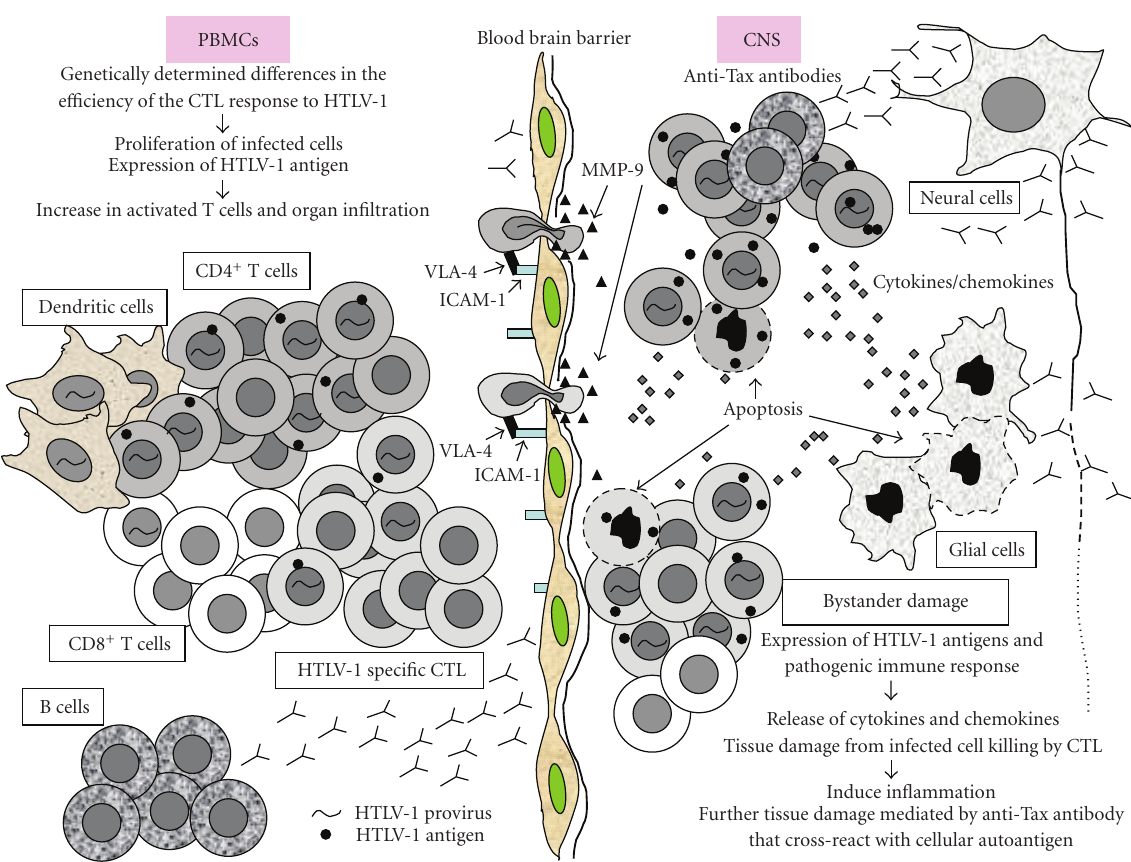
Figure 1: Hypothesis for the pathogenesis of Human T-cell leukemia virus type 1- (HTLV-1-)associated myelopathy/tropical spastic paraparesis (HAM/TSP) . In patients with HAM/TSP, genetically determined less e ffi cient CTL response against HTLV-1 may cause higher proviral load and antigen expression, leading in turn to activation and expansion of antigen-specific T cell responses, subsequent induction of large amounts of proinflammatory cytokines and chemokines, and progression of HAM/TSP development. It is also possible that the immunoglobulin G specific to HTLV-1-Tax, which cross-reacts with heterogeneous nuclear ribonuclear protein-A1 (hnRNP-A1), is associated with subsequent inflammation following initial tissue